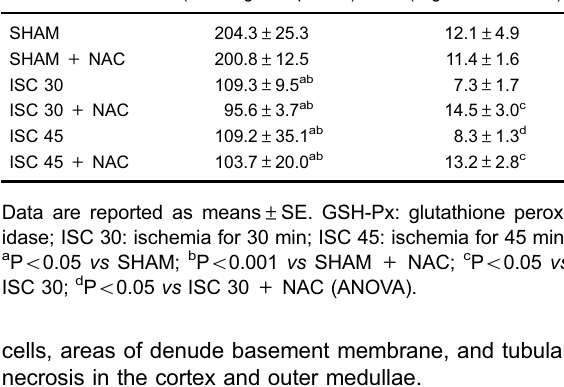
Table 4 . Effect of n-acetylcysteine (NAC) treatment on antioxidant capacity after renal ischemia reperfusion injury.